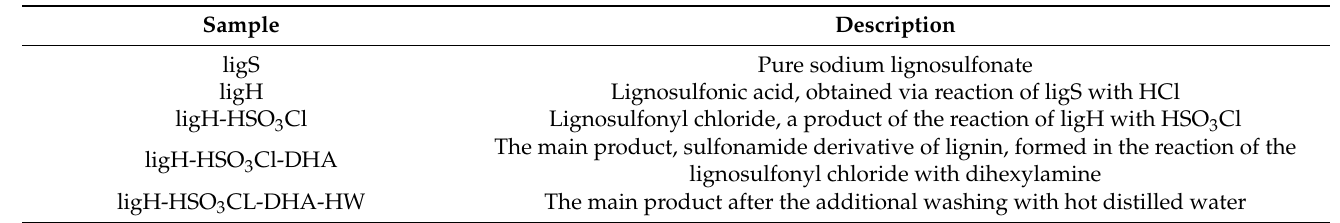
Table 1. Details of the obtained